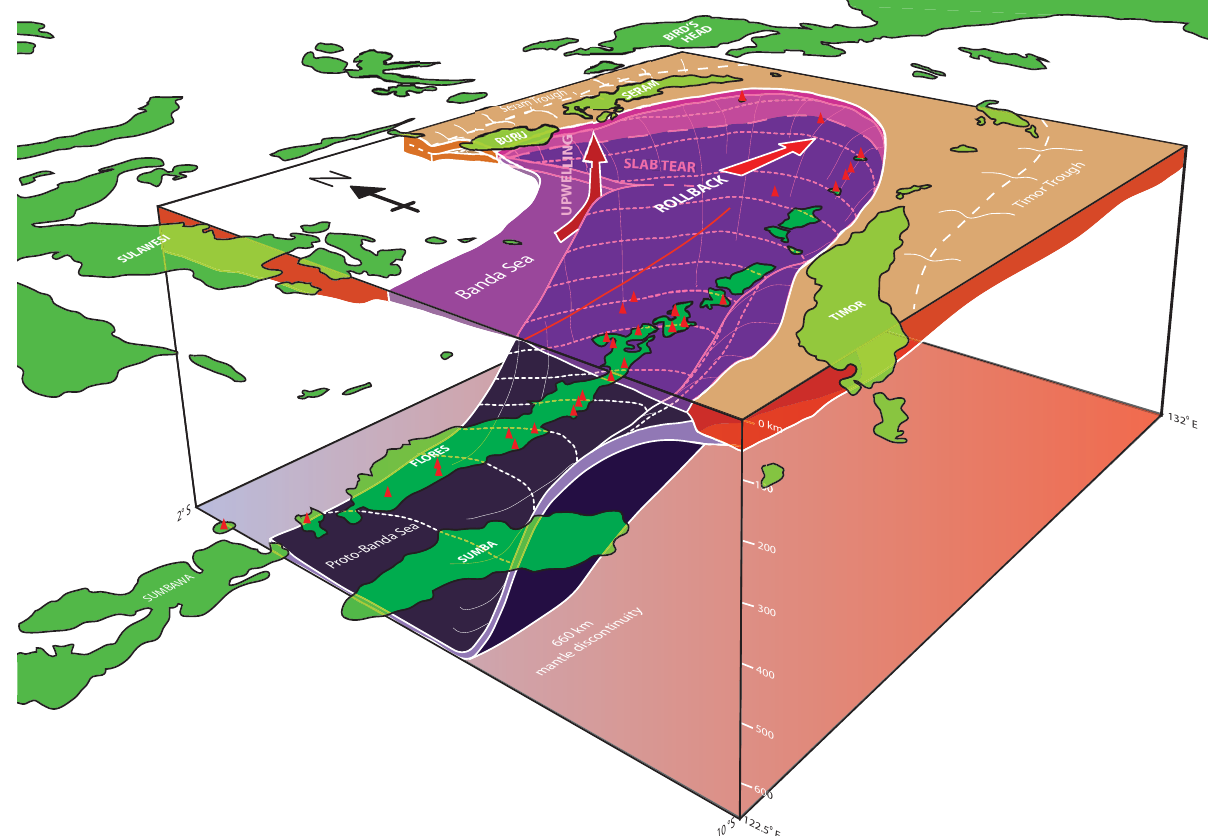
Fig. 2. A 3-D model of the Banda Arc based on earthquake hypocentre locations (Das, 2004) and seismic tomography (Spakman and Hall, 2010). Eastward subduction rollback of the Proto-Banda Sea (dark purple) into a pre-existing D-shaped embayment in the Australian continental margin (light brown) is thought to explain the slab’s extreme curvature. An aseismic zone beneath Buru is interpreted to be due to a tear in the slab that has caused the northern part of the slab west of Buru to have detached and collapsed into the mantle to rest on the 660km discontinuity. The box is drawn between 122.5–132 ◦ E and 2–10 ◦ S to 660km depth. Red triangles represent